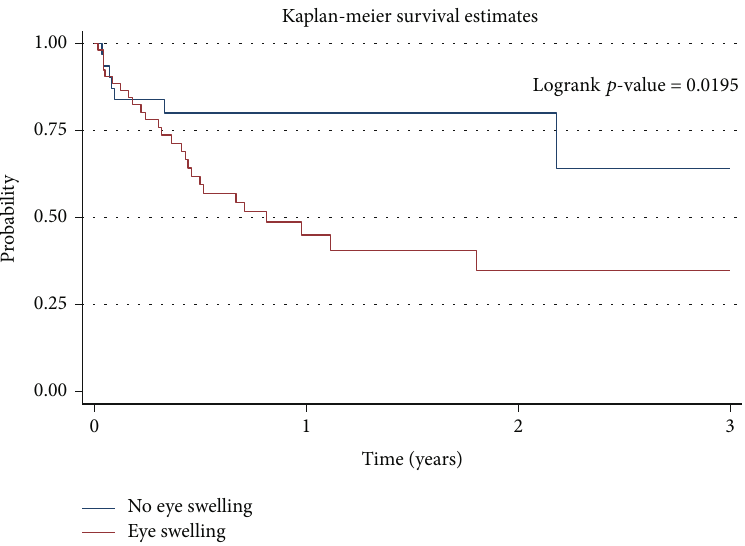
Figure 2: Graph showing the 3-year survival of children with retinoblastoma by history of eye